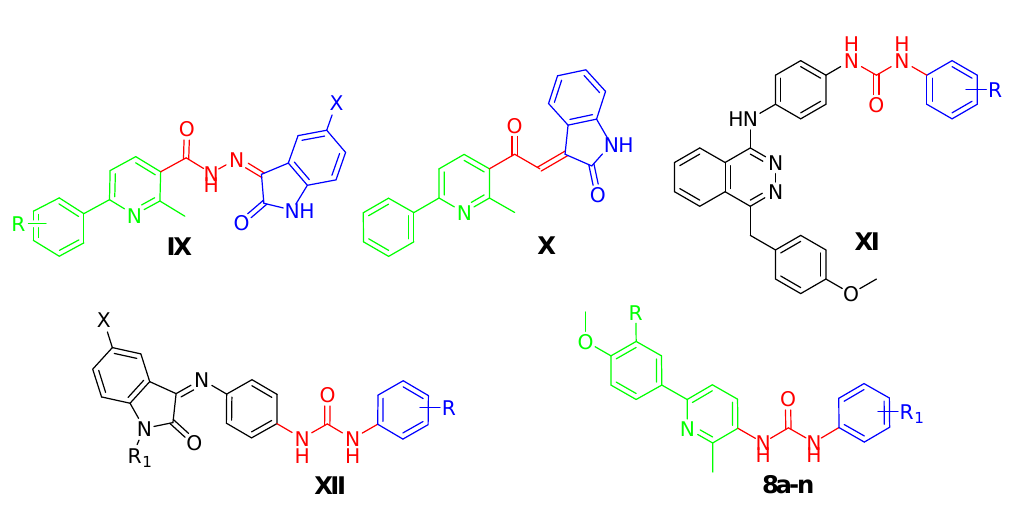
Figure 2. Structures of some pyridine ‐ /urea ‐ based anticancer agents reported by our research group ( IX – XII ), and the target pyridine ‐ ureas 8a – n .